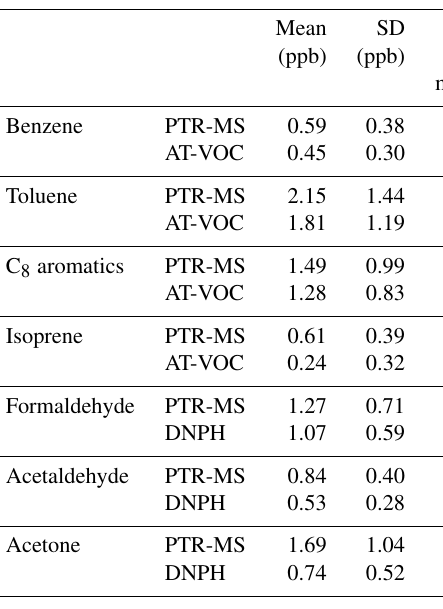
Table 4. The means and SDs of the atmospheric data; the estimated measurement uncertainties of the means ( k = 2) (see Supplement); the 95% confidence limit of the means (ppb) for the seven compounds measured by PTR-MS, AT-VOC and DNPH; and the number of paired observations, N , in this